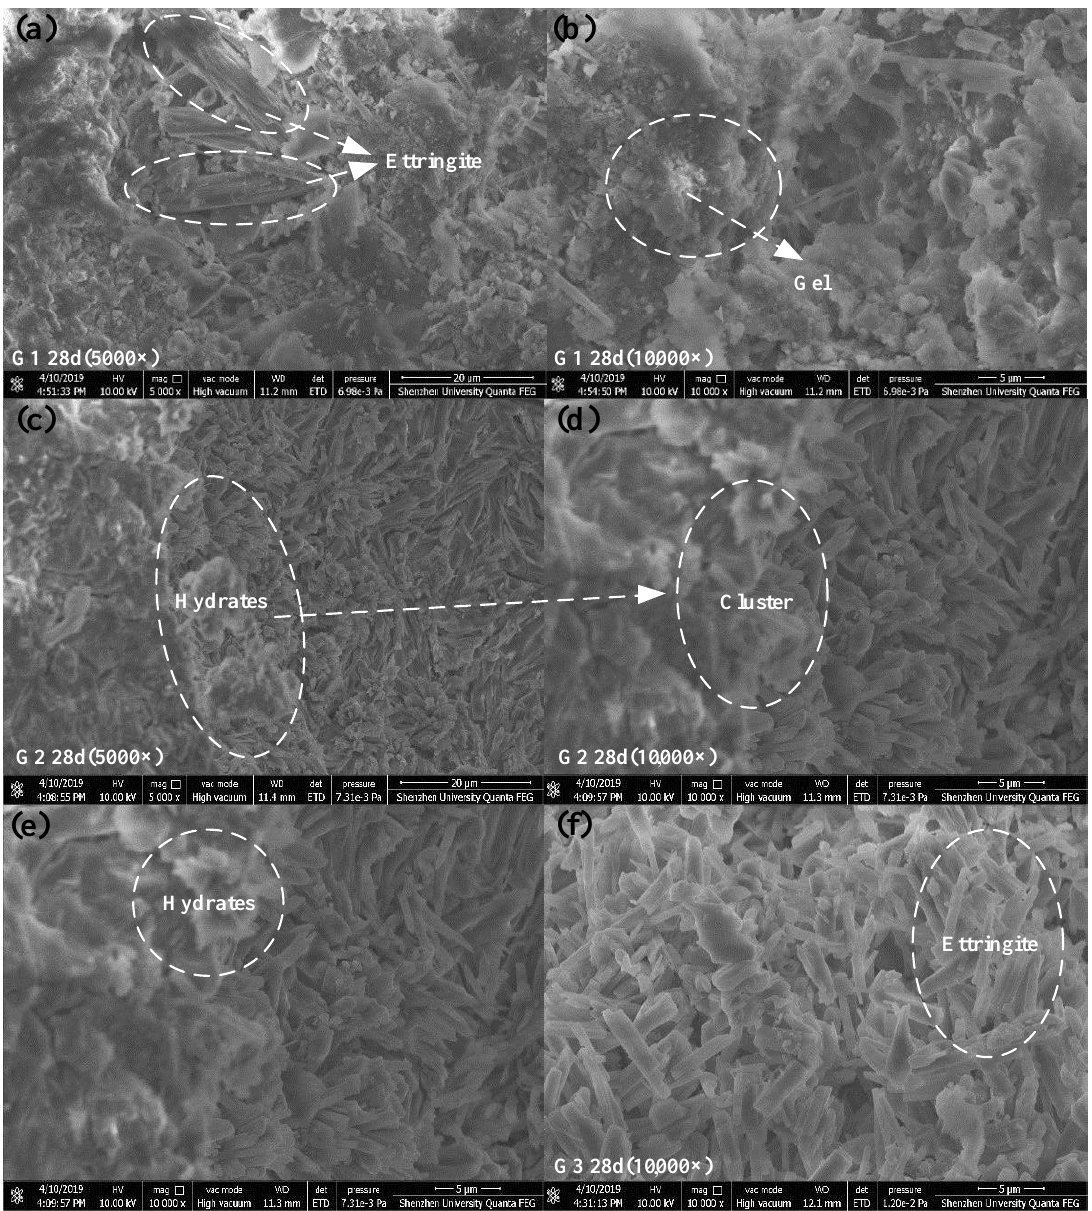
Figure 9. SEM images of the microscopic morphology of the G1, G2, and G3 samples at 28 d. ( a , b ) SEM image of G1 sample at 28d; ( c , d ) SEM image of G2 sample at 28d; ( e , f ) SEM image of G3 sample at 28d.